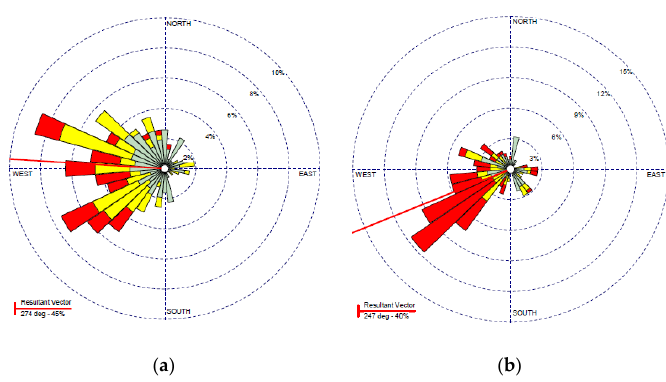
Figure 2. Wind roses during the study period in CEN ( a ) and MIR ( b ) sites. Wind speed (m/s): ě